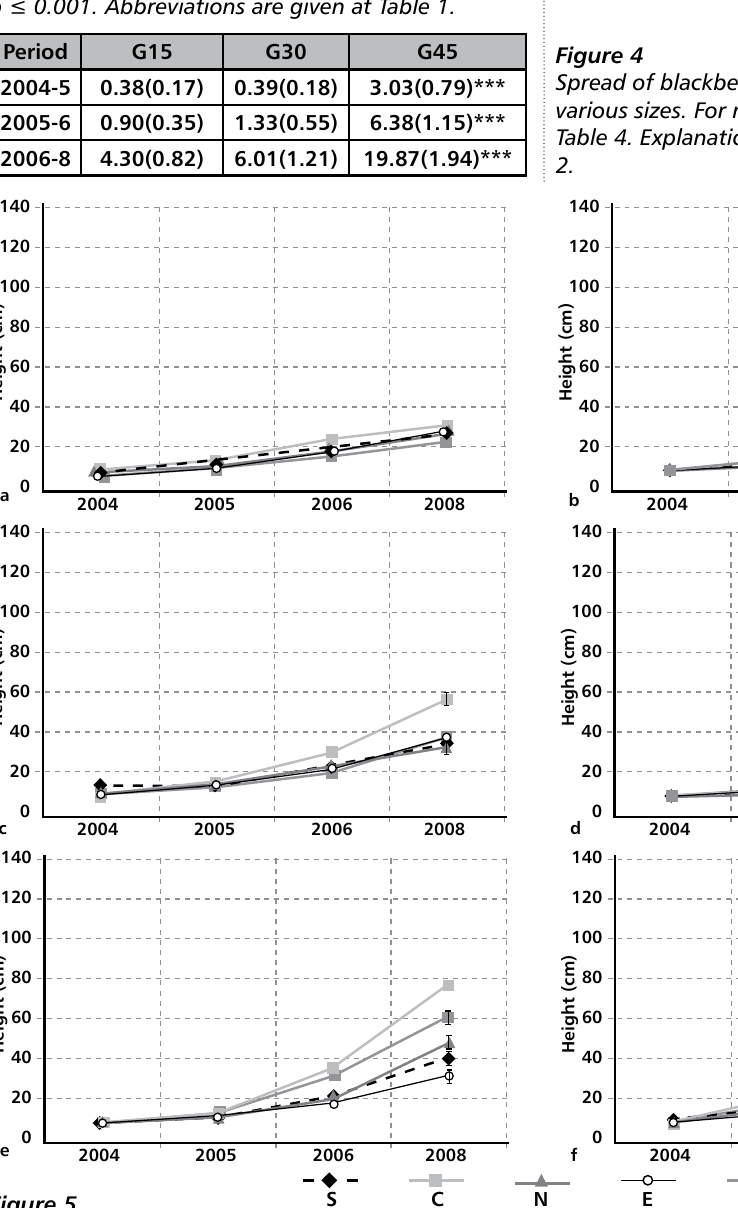
Table 4 Spread of blackberry following cutting gaps of various sizes. The cells contain average values (in %) of change in cover during a given period. Standard errors are shown in brackets. By the significance tests, medium-size gaps were compared to the largest and to the smallest ones. Significance levels are indicated by asterisks in the upper index of values of the latter gaps. Observation numbers equal the numbers of the 1 x 1 m quadrats (Table 1). *** - p ≤ 0.001. Abbreviations are given at Table G30 Figure 4 Spread of blackberry following cutting gaps of various sizes. For results of significance tests, see Table 4. Explanations are given at Table 1 and Figure 2.